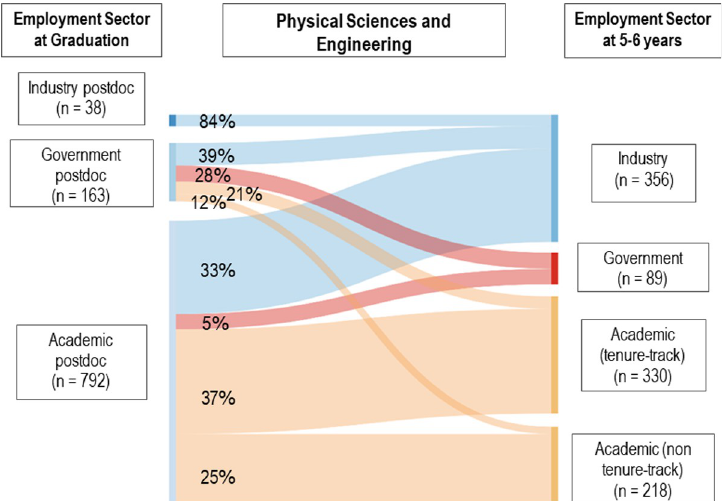
Fig 1. Sankey diagram of physical sciences and engineering postdoc movement to permanent employment.